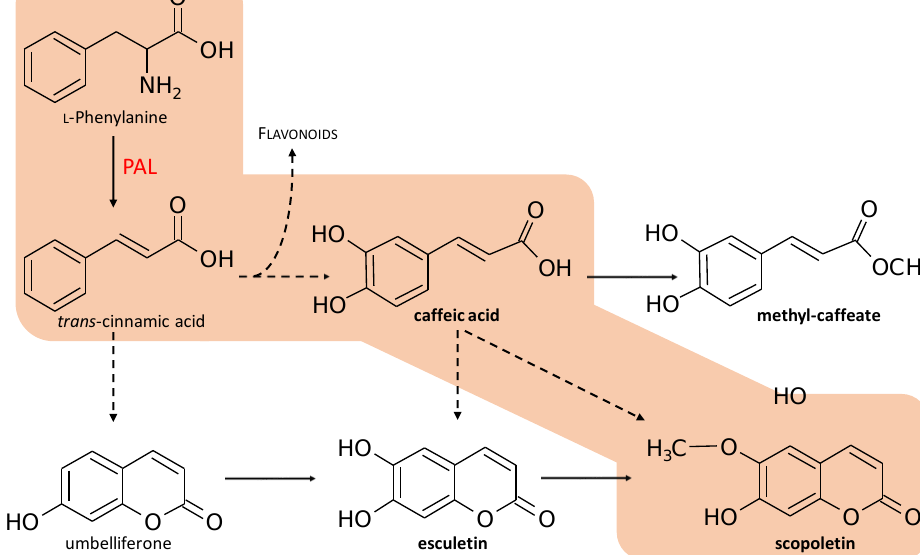
Figure 1. Schematic view of the phenylpropanoid pathway leading to the production of flavonoids, phenolics (in particular, caffeic acid and methyl-caffeate) and coumarins (in particular, esculetin and scopoletin). PAL: l -phenylalanine ammonia-lyse. Adapted from Bourgaud et al. [18] and Karamat et al.